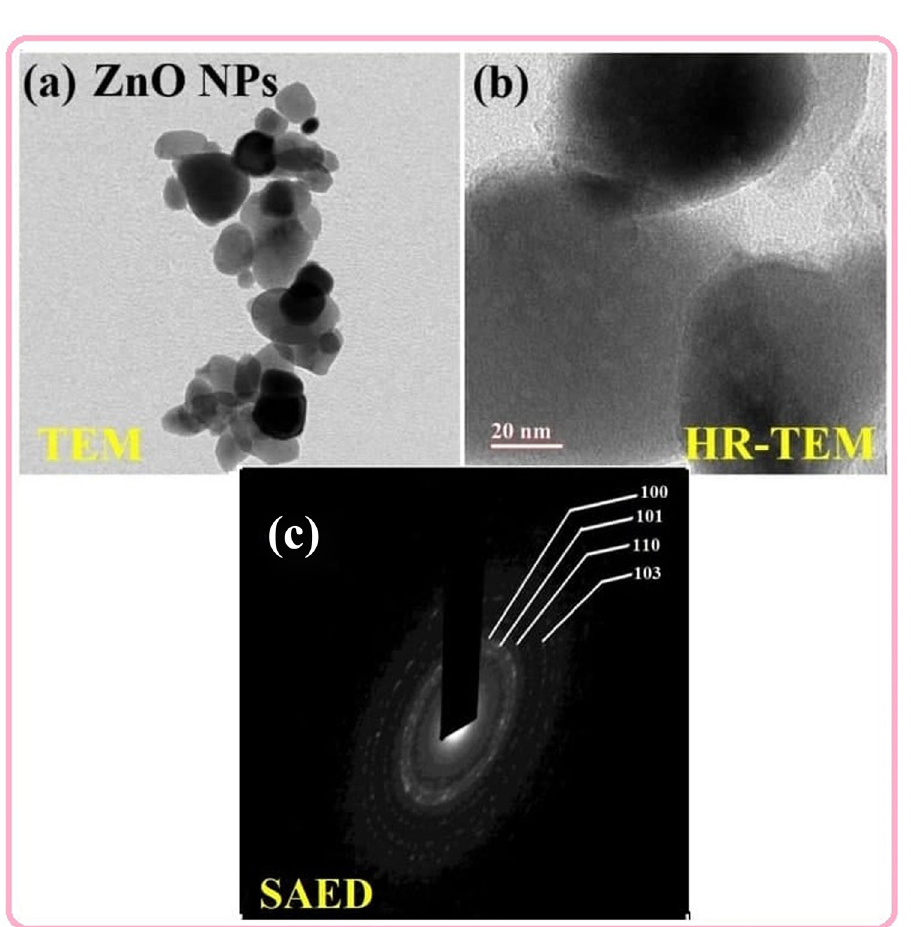
Figure 4: HRTEM analysis of ZnO NPs ( a ) showing that the NPs are spherical in high - resolution transmission electron microscopy ( b ) and the SAED pattern of the NP ( c )